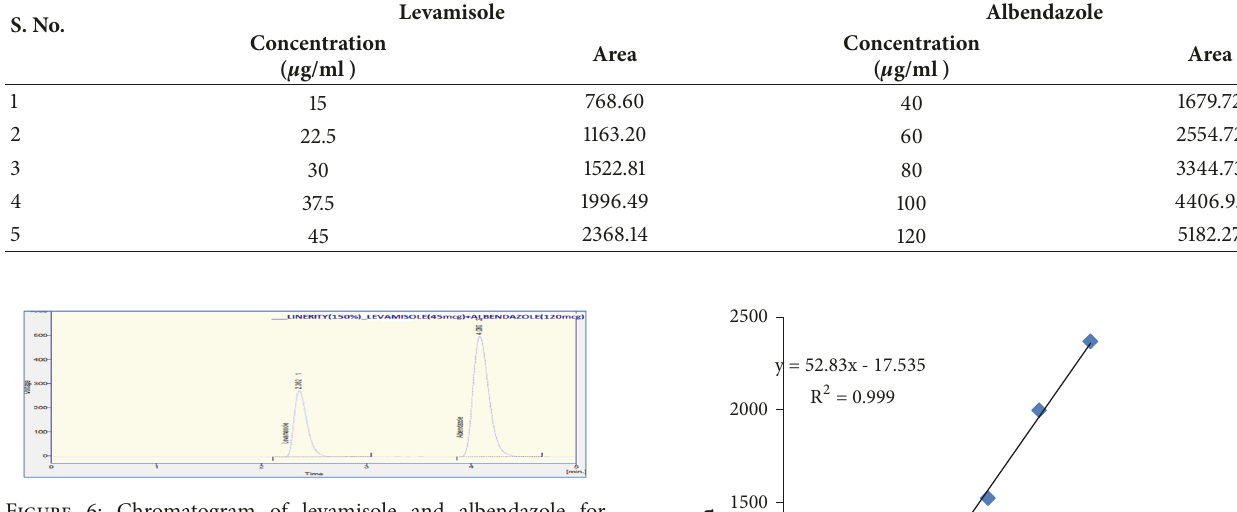
Figure 6: Chromatogram of levamisole and albendazole for preparation-5.